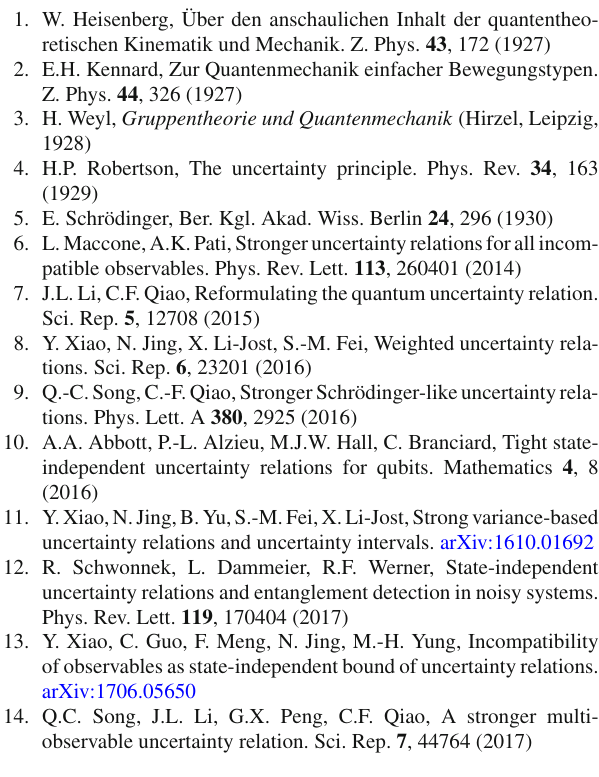
is always better than U 1 . For different Ω and R 0 , Δ 2 is constant while Δ 1 increases as Ω and R 0